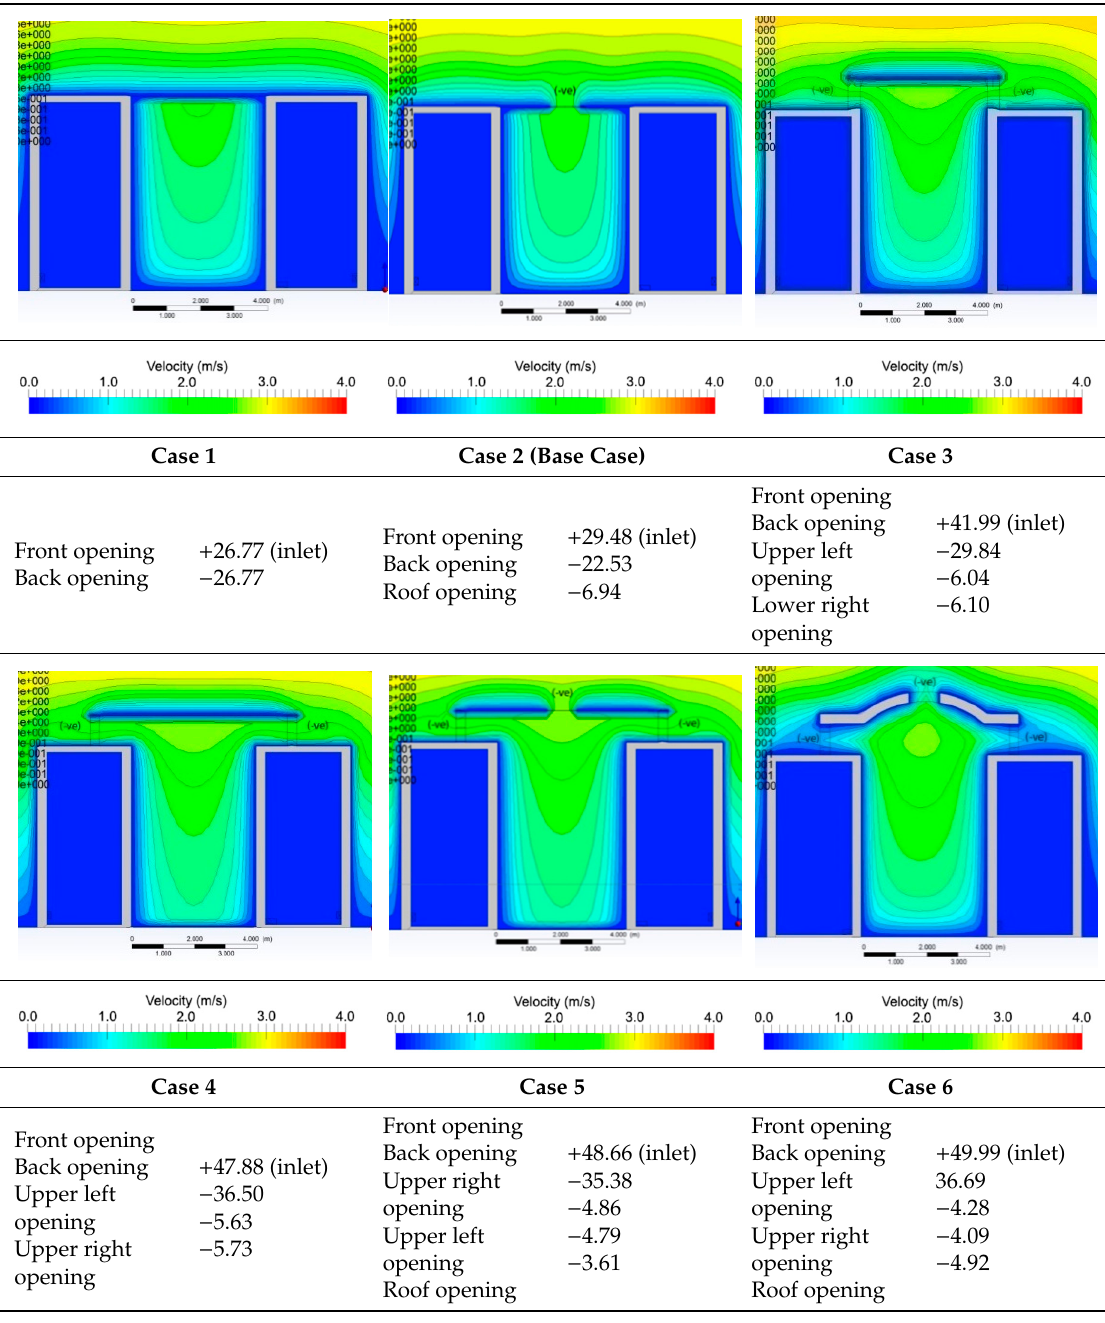
Figure 11. Total volume flow rate (m 3 /s). 01020 3040 50 60